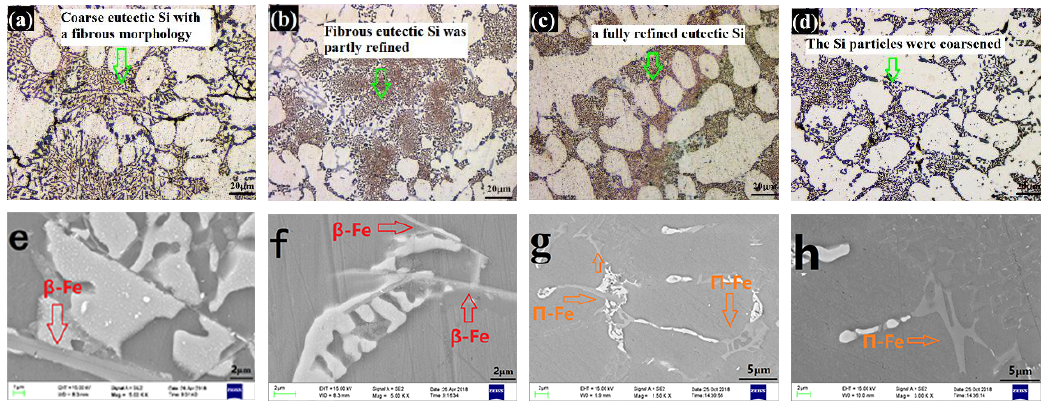
Figure 4. The morphology of the eutectic Si by OM and the size and texture of Fe-rich phases by SEM of Al9Si1.2Cu0.4Mg (0 wt% – 0.9 wt% Zn) in as-cast conditions: ( a , e ) free-Zn, ( b , f ) 0.3 wt% Zn, ( c , g ) 0.6 wt% Zn, ( d , h ) 0.9 wt%